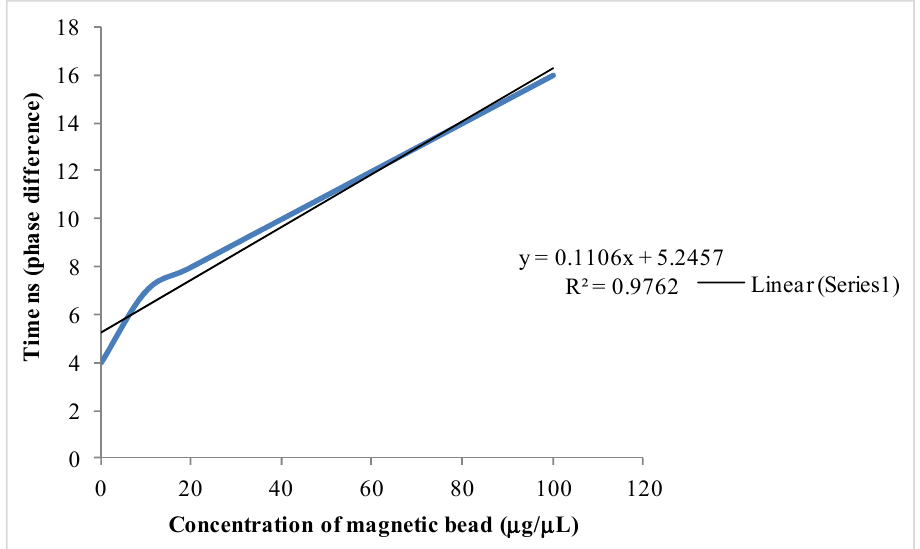
Figure 13. Graph indicating linearity of the magnetic field measurements from different sets of magnetic